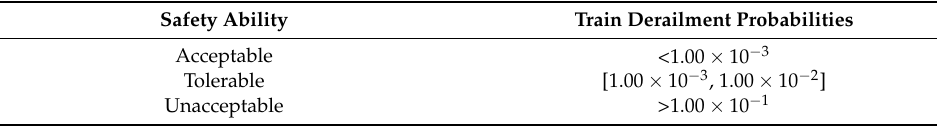
Table 6. Assessment criteria for the safety level.